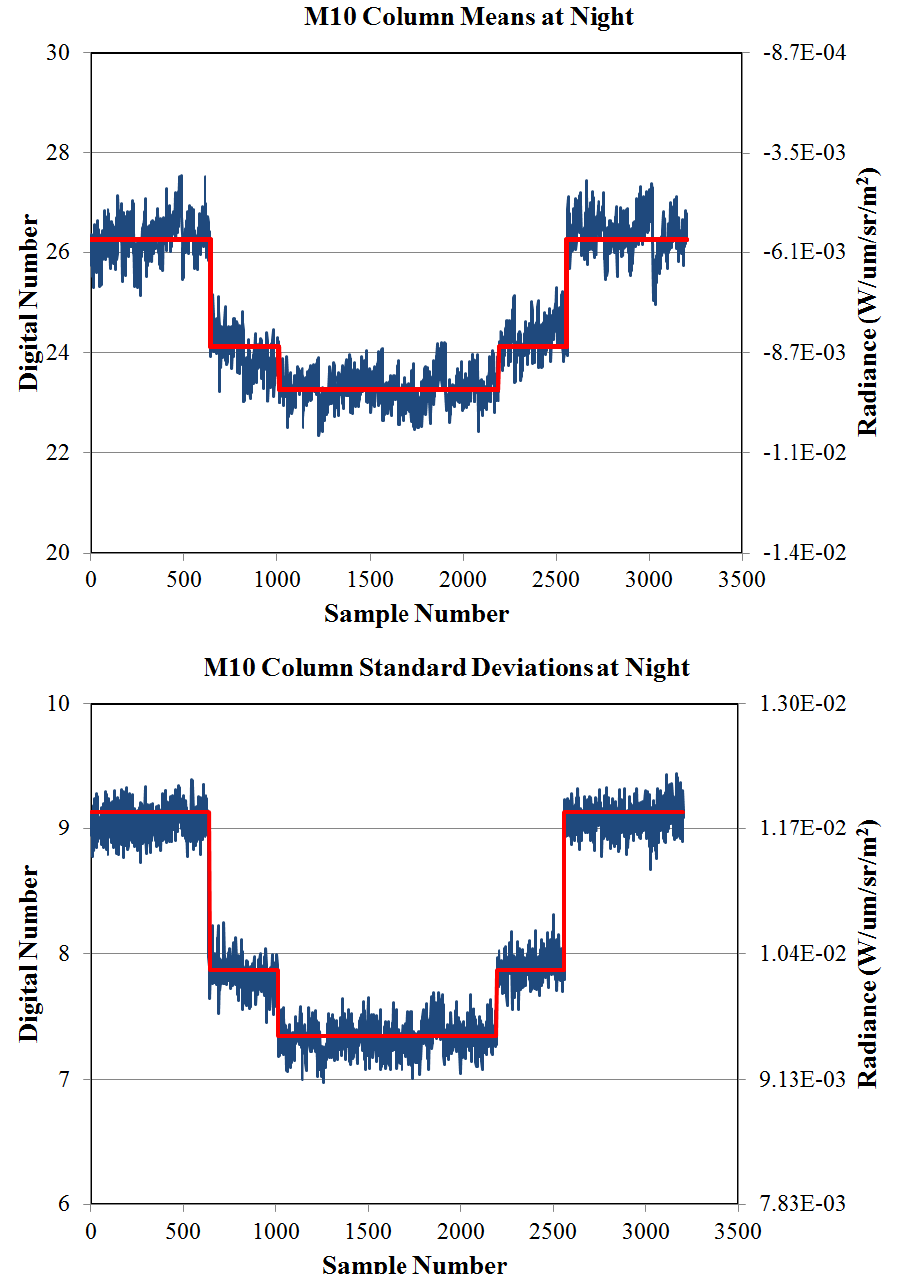
Figure 4. Charts show variability of column means and standard deviations for an M10 image collected over ocean with no combustion sources present the night of 5 March 2013. Note that the three detector aggregation zones show up in both the mean and standard deviation, which are lowest in zone 1 and step up incrementally in zone 2 and zone 3. The detection threshold analysis is performed on the unsigned integers provided in the SDR. These can be converted to radiances by applying a scale and offset. A slight error is indicated in the offset term, resulting in negative radiance